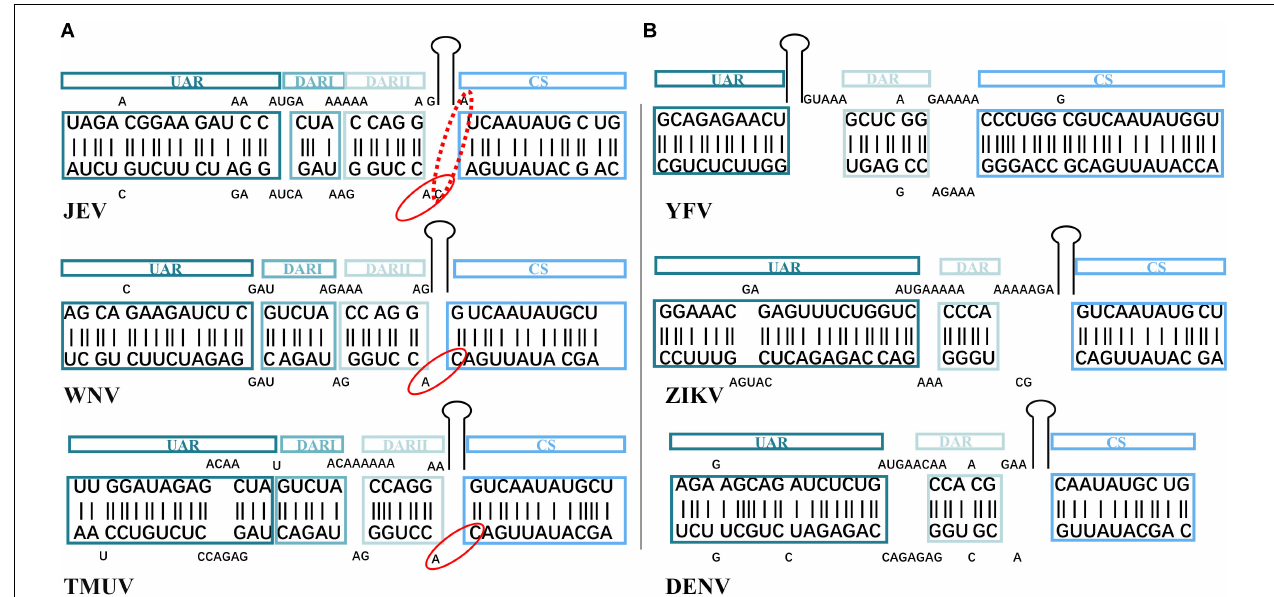
FIGURE 2 | Similarity and difference on complementary sequences of representative MBFVs. The corresponding color for each structural motif (5 (cid:48) UAR/3 (cid:48) UAR, 5 (cid:48) DARI/3 (cid:48) DARI, 5 (cid:48) DARII/3 (cid:48) DARII, and 5 (cid:48) CS/3 (cid:48) CS elements) is maintained as in Figure 1 representation. (A,B) Are the bird-adaptable and none-bird adaptable flavivirus groups, respectively. The neighboring nucleotides of the conserved 5 (cid:48) CS/3 (cid:48) CS are inconsistent in the bird-adaptable MBFVs. Owing to the unpaired A/C in the dashed ovals of JEV, the dinucleotides in solid ovals distinguish the JEV from other bird-adaptable